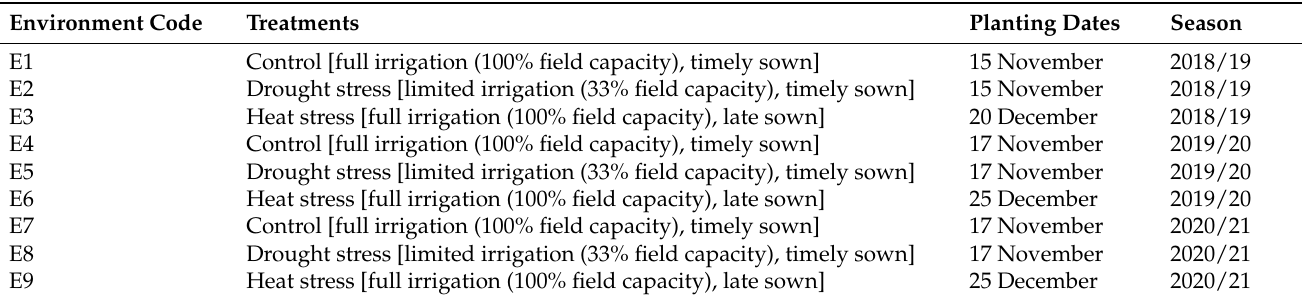
Table 1. Codes used and description of the test for production